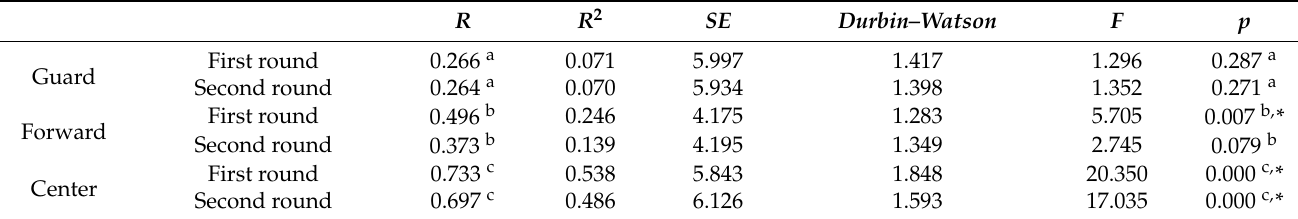
Table 7. Results of the prediction